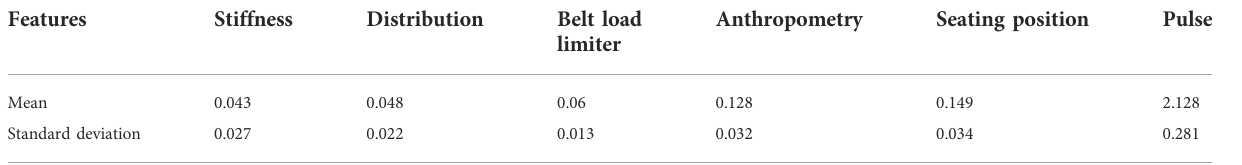
TABLE 6 Permutation feature importance for HIC15.